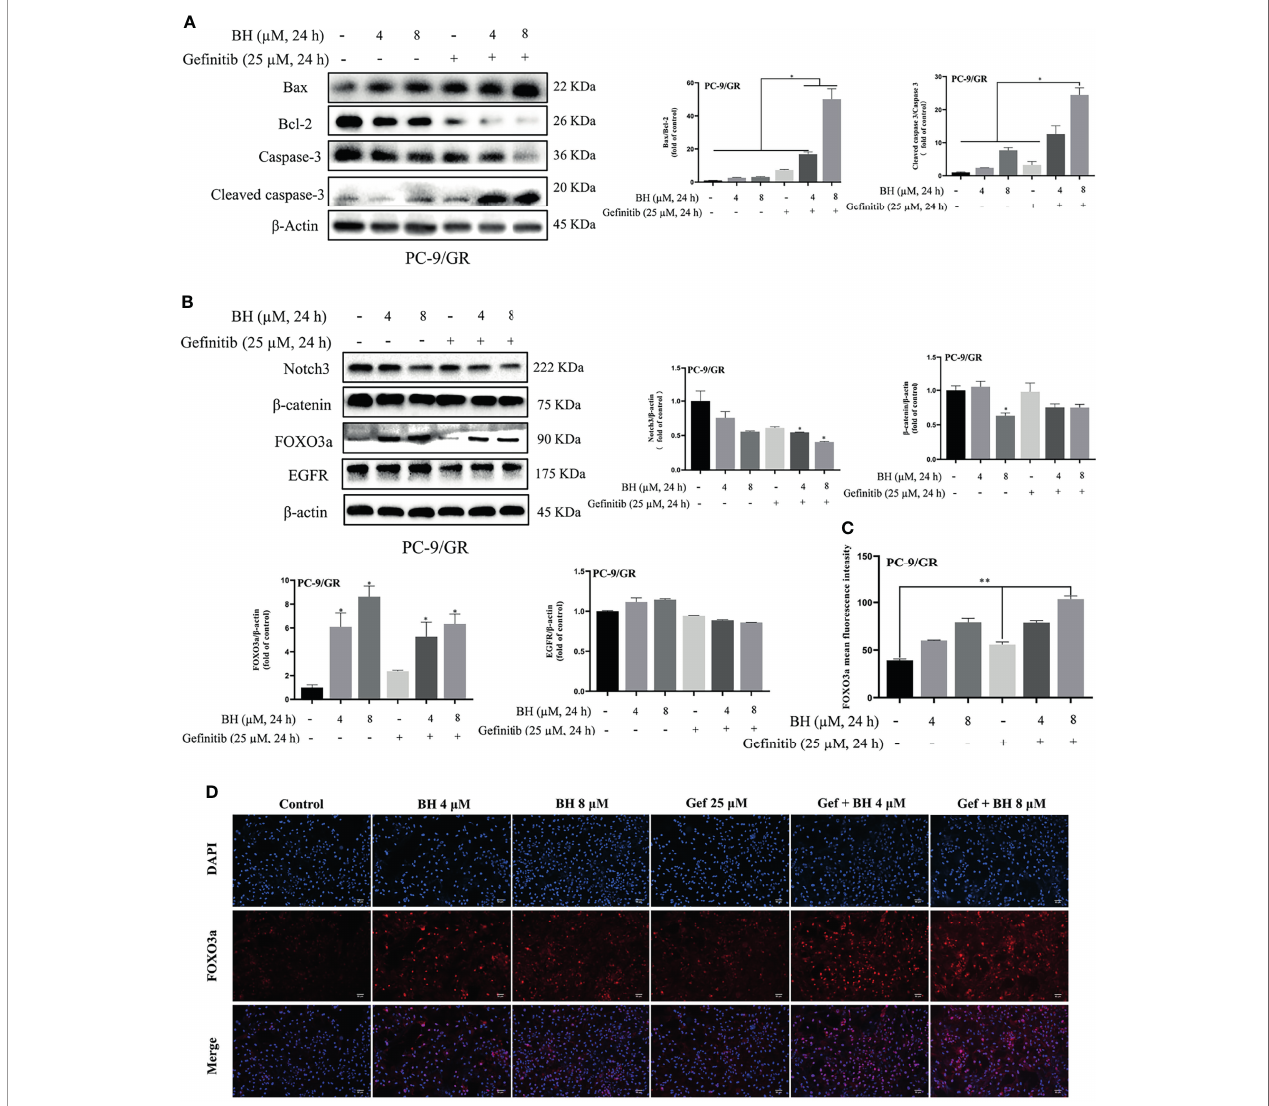
FIGURE 4 | BH modulates the expression of multiple proteins. (A) Western bolt was used to detect the expression of cleaved caspase-3, caspase-3, Bcl-2, and Bax protein. (B) The protein levels of Notch3, b -catenin, FOXO3a, and EGFR in PC-9/GR cells treated with BH (4, 8 m M) and/or ge fi tinib (25 m M) for 24 h. (C, D) Immuno fl uorescent images of PC-9/GR cells represented the accumulation of FOXO3a. Scale bars, 50 m m. “ * ” represents Gef +BH group, BH group, Gef group vs. the Control group (*p < 0.05, **p <